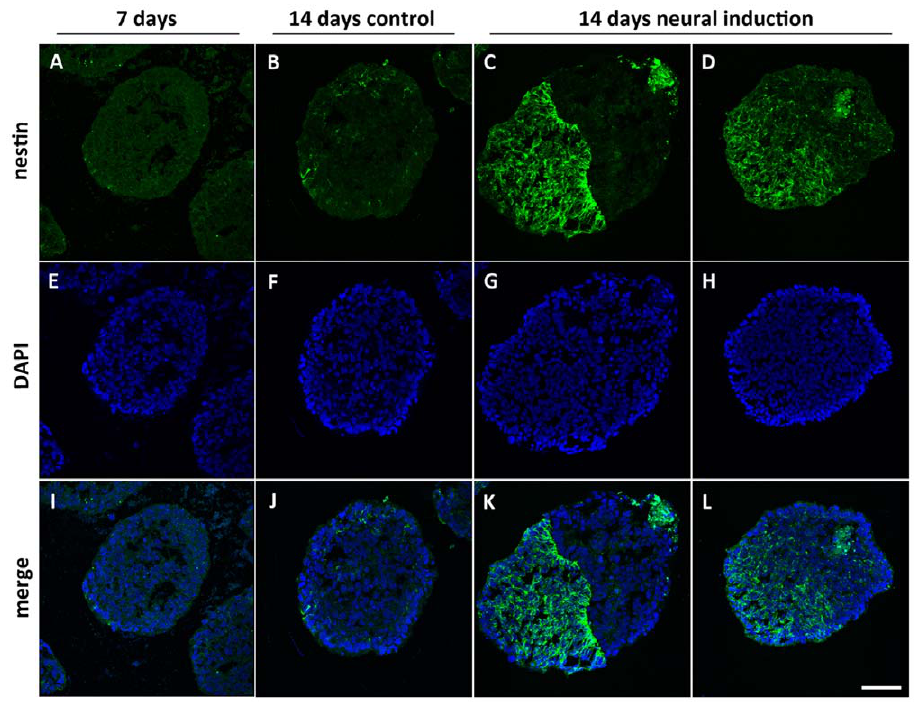
Figure 7. Nestin expression is polarized after neural induction in human embryoid bodies. Nestin staining of H9 embryoid bodies, A) 7 days old group; B) 14 days old control group; C and D) 14 days old neural induced group. E to H) DAPI staining; I to L) merge. The embryoid bodies depicted in this figure are corresponding examples of the total population. Scale bar 50 m m.